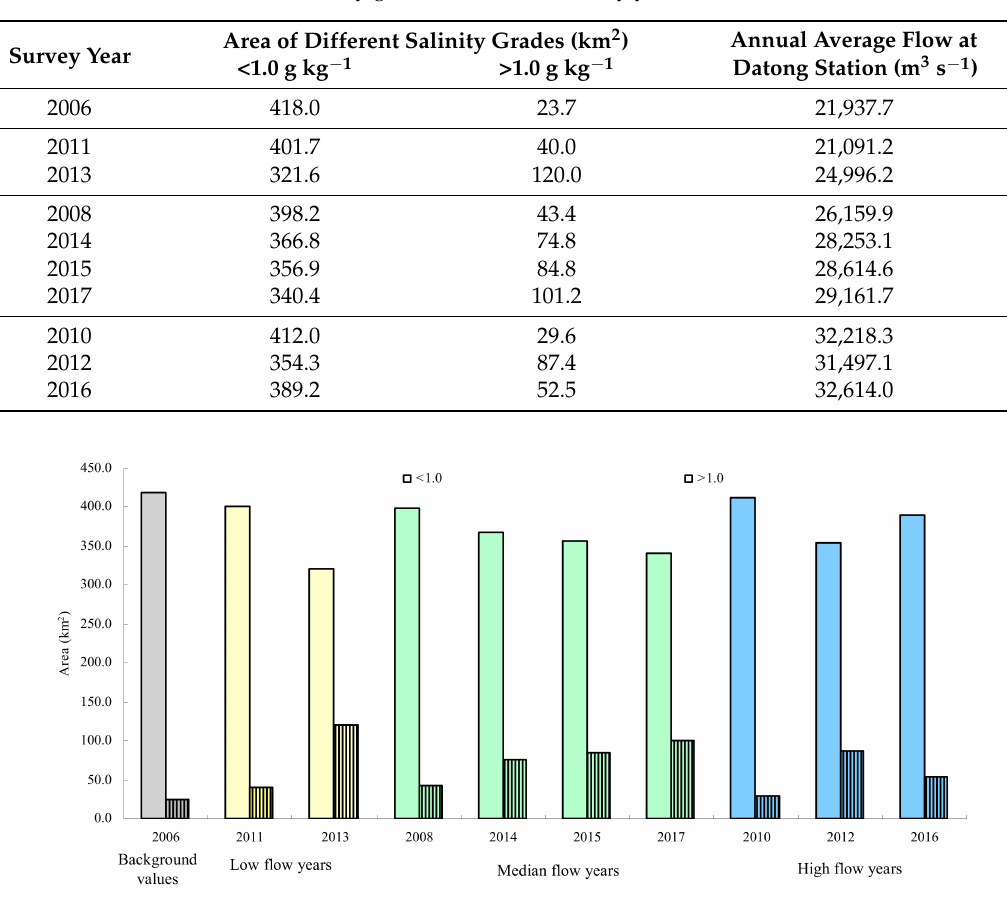
Table 4. Area of different salinity grades in different survey years.